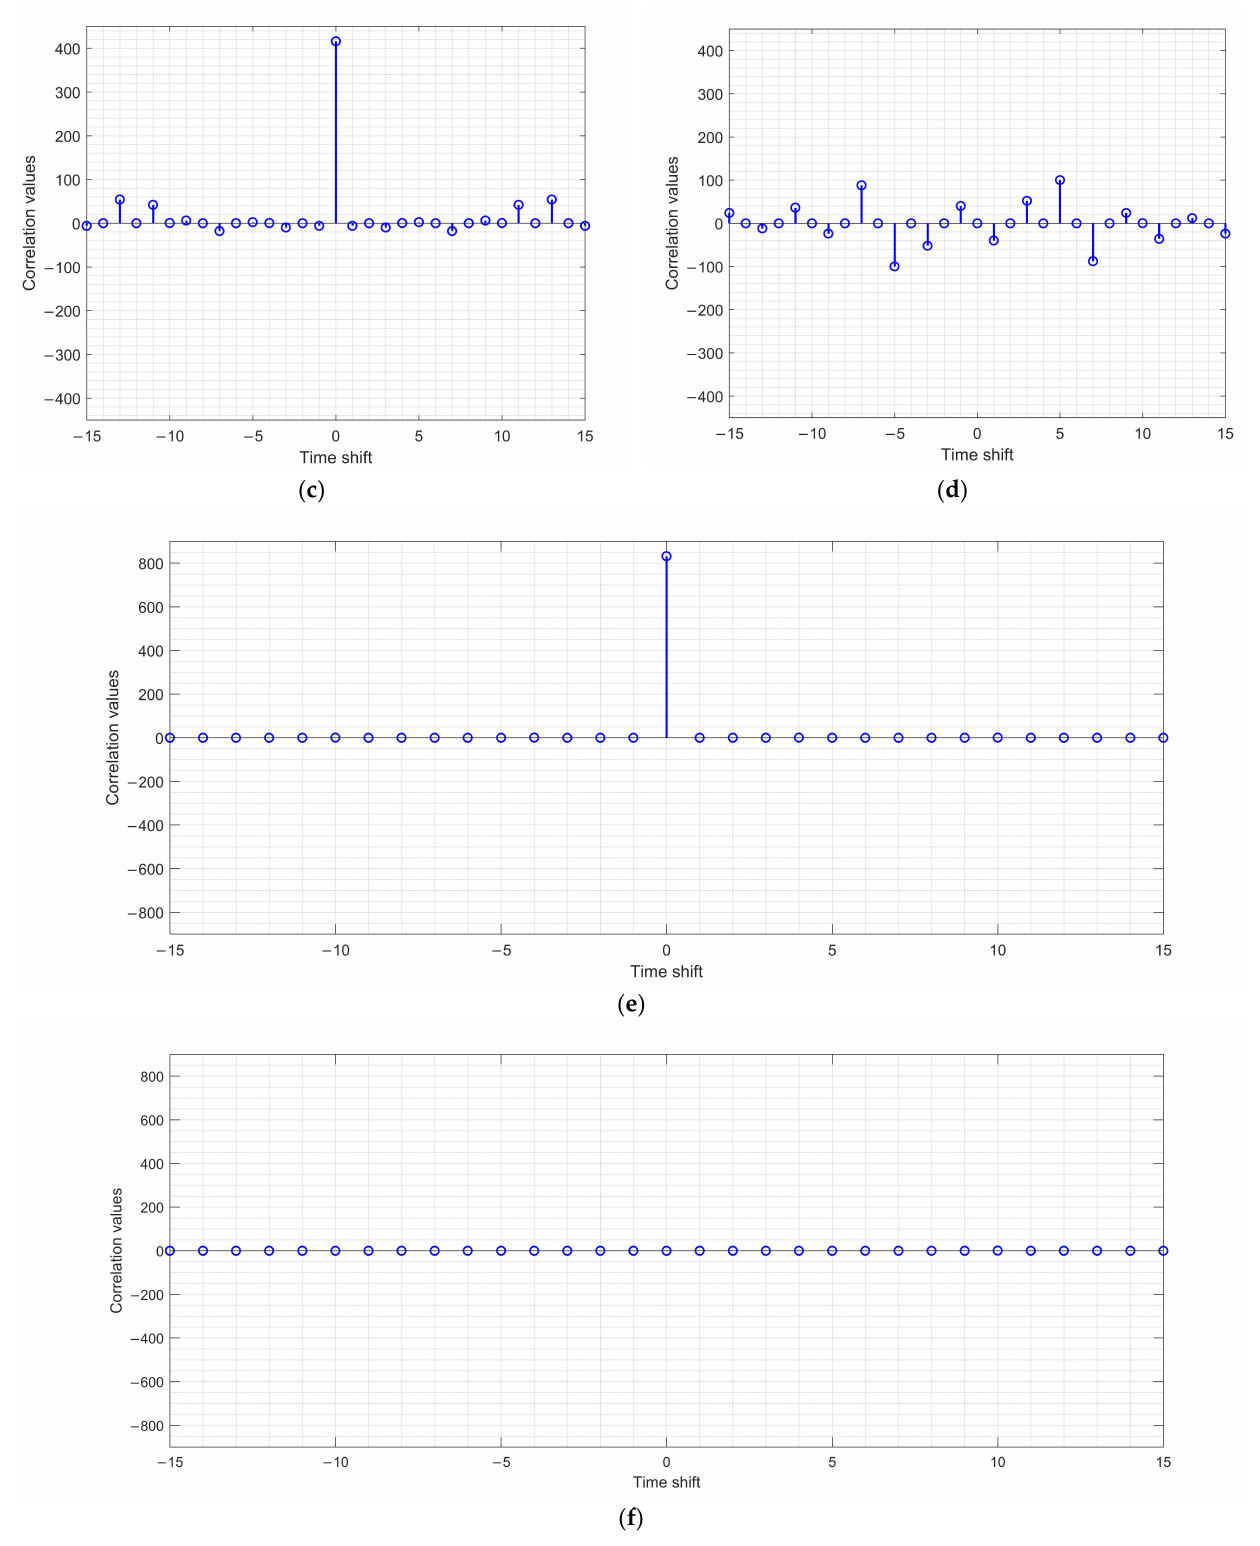
Figure 3. The autocorrelation functions of the proposed 64-QAM GCSs in (39): ( a ) Real part of A ’s autocorrelation function 𝐶 𝑨 (𝜏) ; ( b ) imaginary part of A ’s autocorrelation function 𝐶 𝑨 (𝜏) ; ( c ) real part of B ’s autocorrelation function 𝐶 𝑩 (𝜏) ; ( d ) imaginary part of B ’s autocorrelation function 𝐶 𝑩 (𝜏) ; ( e ) real part of the sum of A and B ’s autocorrelation functions 𝐶 𝑨 (𝜏) + 𝐶 𝑩 (𝜏) ; ( f ) imaginary part of the sum of A and B ’s autocorrelation functions 𝐶 𝑨 (𝜏) + 𝐶 𝑩 (𝜏) .